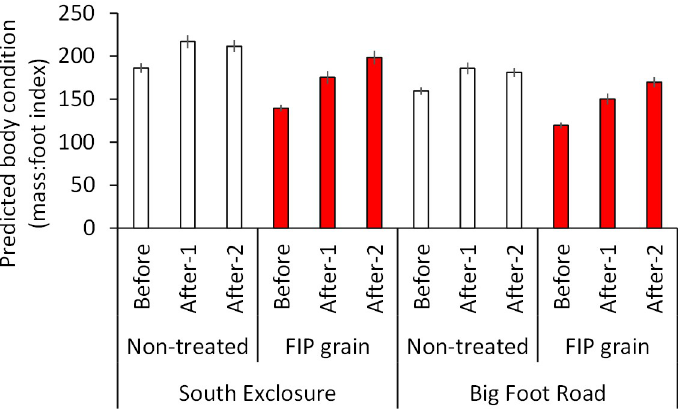
Fig 1. Predicted body condition indices (mass:foot) for black-tailed prairie dogs at South Exclosure and Big Foot Road colonies, South Dakota, USA, 2017. At each colony, data were collected on paired sites treated with 0.005% fipronil (FIP) grain on 24 Jul or left non-treated. Data were collected during 3 BACI (before-after-control-impact) periods: Before FIP grain treatments (June-24 July), After-1 (25 July-30 August), and After-2 (1 September-October). Here, prairie dog ages/sexes are combined for simplicity. Error bars are ± 1 SE